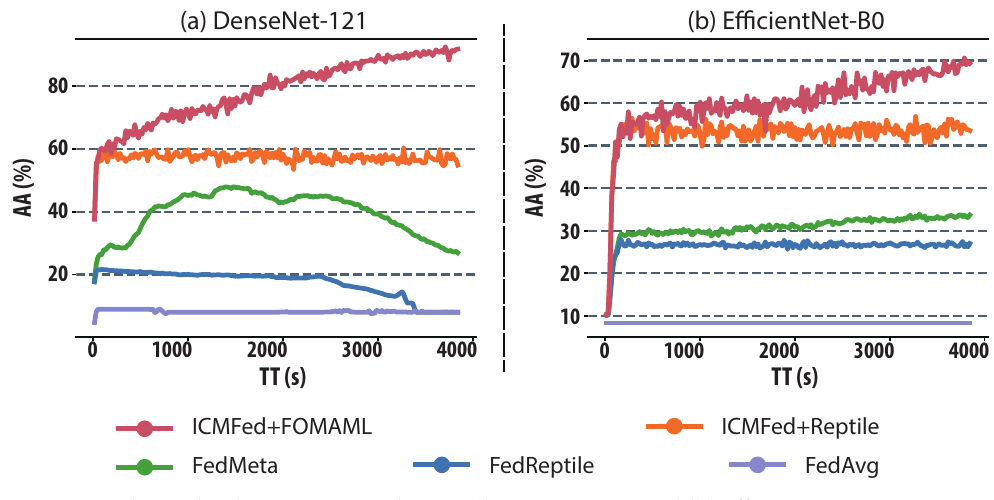
Figure 4. Relationship between AA and TT in ( a ) DenseNet-121 and ( b ) EfficientNet-B0